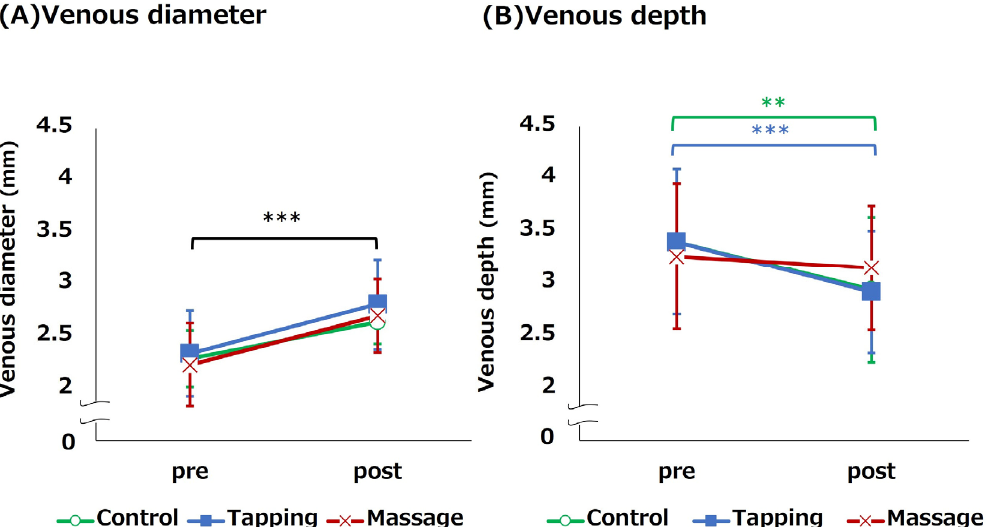
Figure 4. Venous dilation effects in thin vein group (n = 9). Notes: Control, Control condition; Tapping, Tapping condition; Massage, Massage condition; paired t -test, ** p < 0.01 *** p < 0.001 (( A ), all conditions were significantly larger between pre and post; ( B ), Control and Tapping conditions were significantly larger between pre and post); linear mixed-effects model (one-way repeated-measures analysis of variance (ANOVA)) and Dunnett test. The bars at each time point indicate 95% confidence intervals.